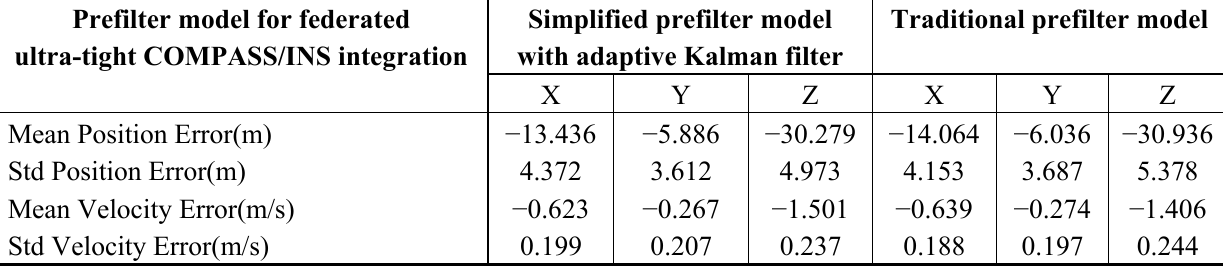
Table 4. Statistics of position and velocity errors in ECEF frame with different prefilter models. Prefilter model for federated